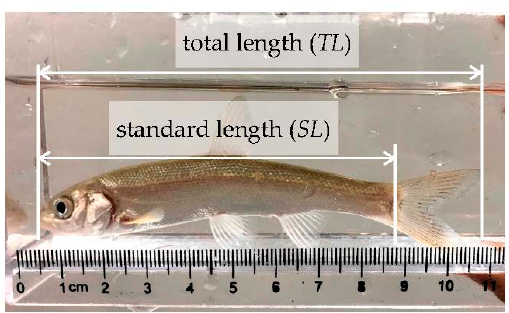
Figure 6. Tribolodon hakonensis ; Ugui.